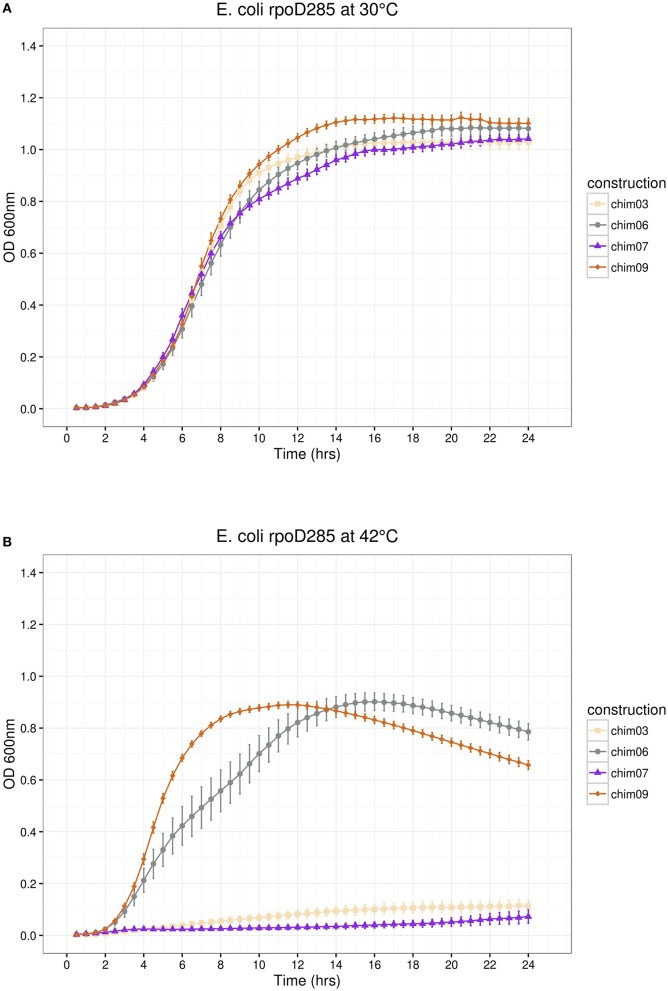
E. coli rpoD285 complementation experiments. pRKch03, wheat squares; pRKch06, azure 4 circles; pRKch07, blue violet triangles and pRKch09, chocolate diamonds. (A) Growth temperature, 30°C. (B) Growth temperature, 42°C. Twenty repetitions were done for each construction. Error bars denote SEM.